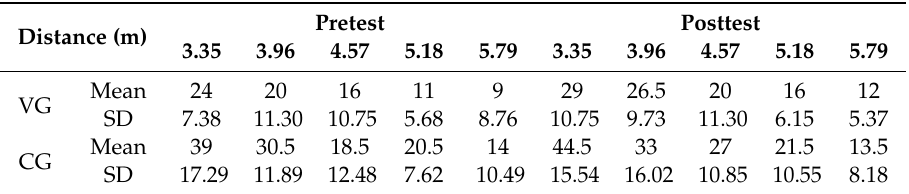
Table 1. Average percent accuracy scores for each distance in the pretest and posttest in variable group (VG) and constant group(CG) practice